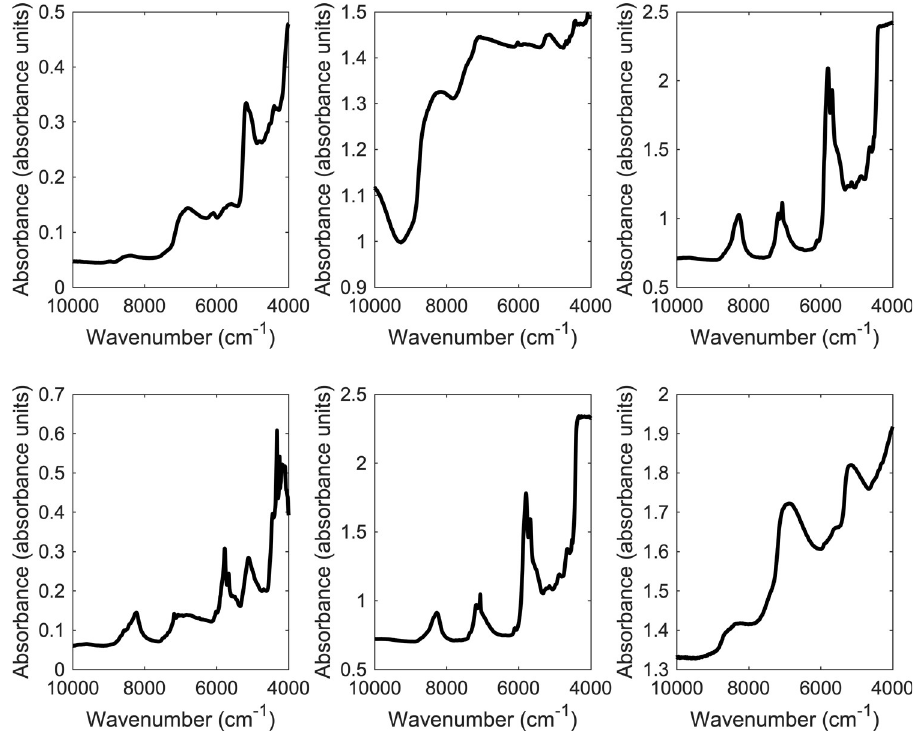
Fig 2. Raw NIR spectrum for (a) mRNA, (b) normal saline solution, (c) excipient 1, (d) excipient 2, (e) excipient 3 and (f) COVID-19 vaccine sample measured using the Perkin Elmer Spectrum II NIR spectrometer in diffuse reflectance